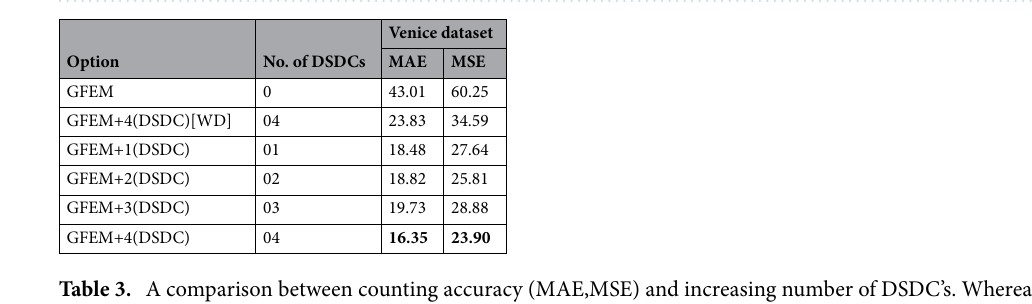
Figure 4. Visualization of Venice dataset, ground truth density, estimated density.